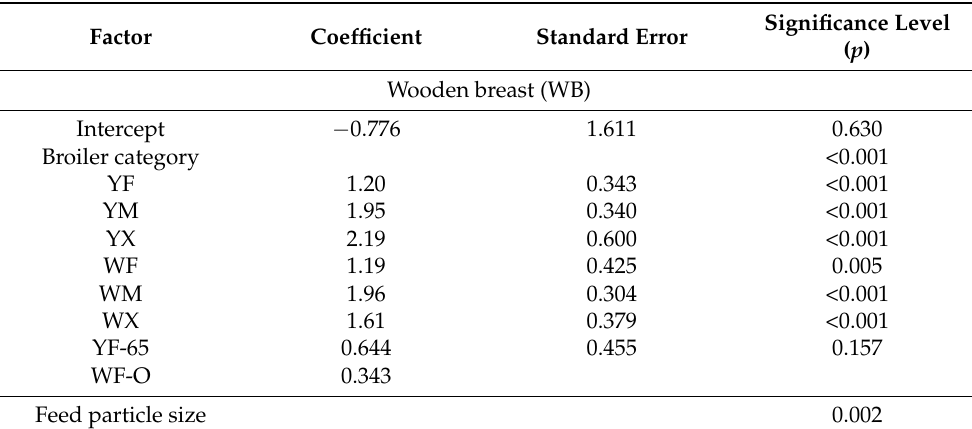
Table 2. Significant effects of the variables studied on the incidence of wooden breast (WB) and spaghetti meat